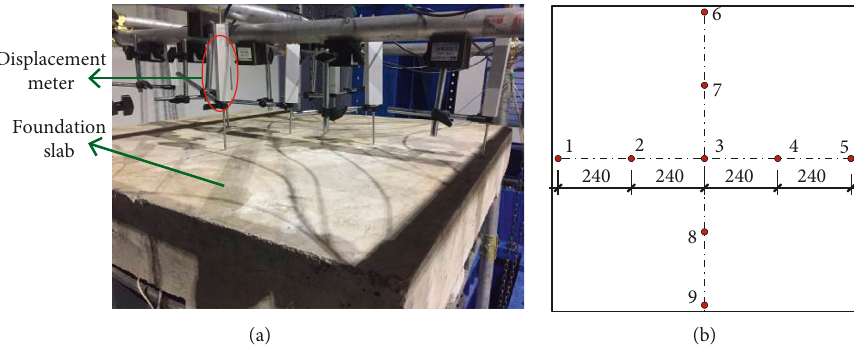
Figure 5: Arrangement of the displacement meters for the specimen. (a) Displacement meters. (b) Measuring point of deformation. Table 4: Failure characteristics of the test specimens. Specimen